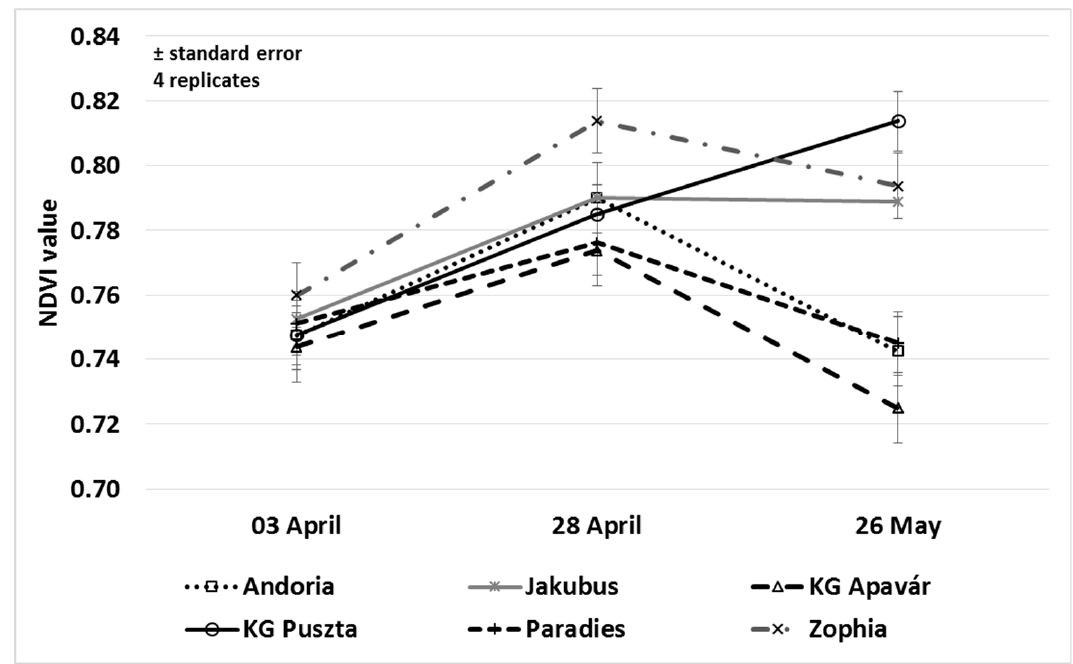
Figure 7. Leaf area index values of winter barley cultivars in the growing season (Debrecen, 2020) Means of N treatments, standard error of means, 4 replicates. Leaf area development of barley plants almost was complete at BBCH 47 − 49 (28 April), statistical analysis did not prove significant differences among the varieties.